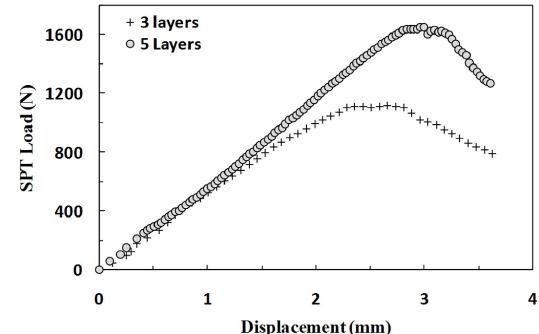
Figure 11. Load versus displacement curve for the 5 and 3 layers samples obtained from SPT (at the same rolling